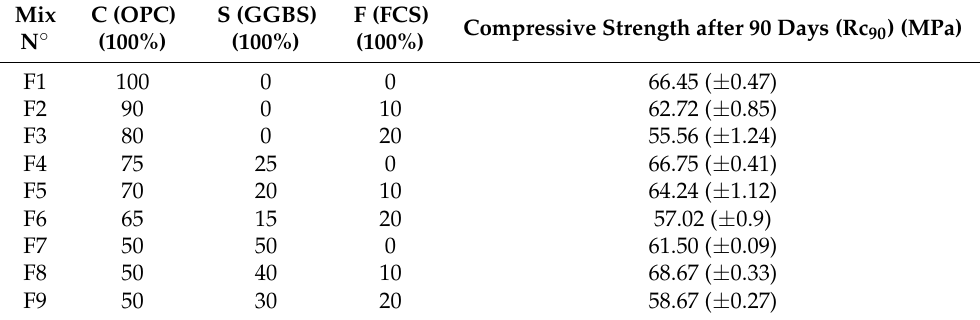
Table 4. Compressive strength results of the selected mixes.